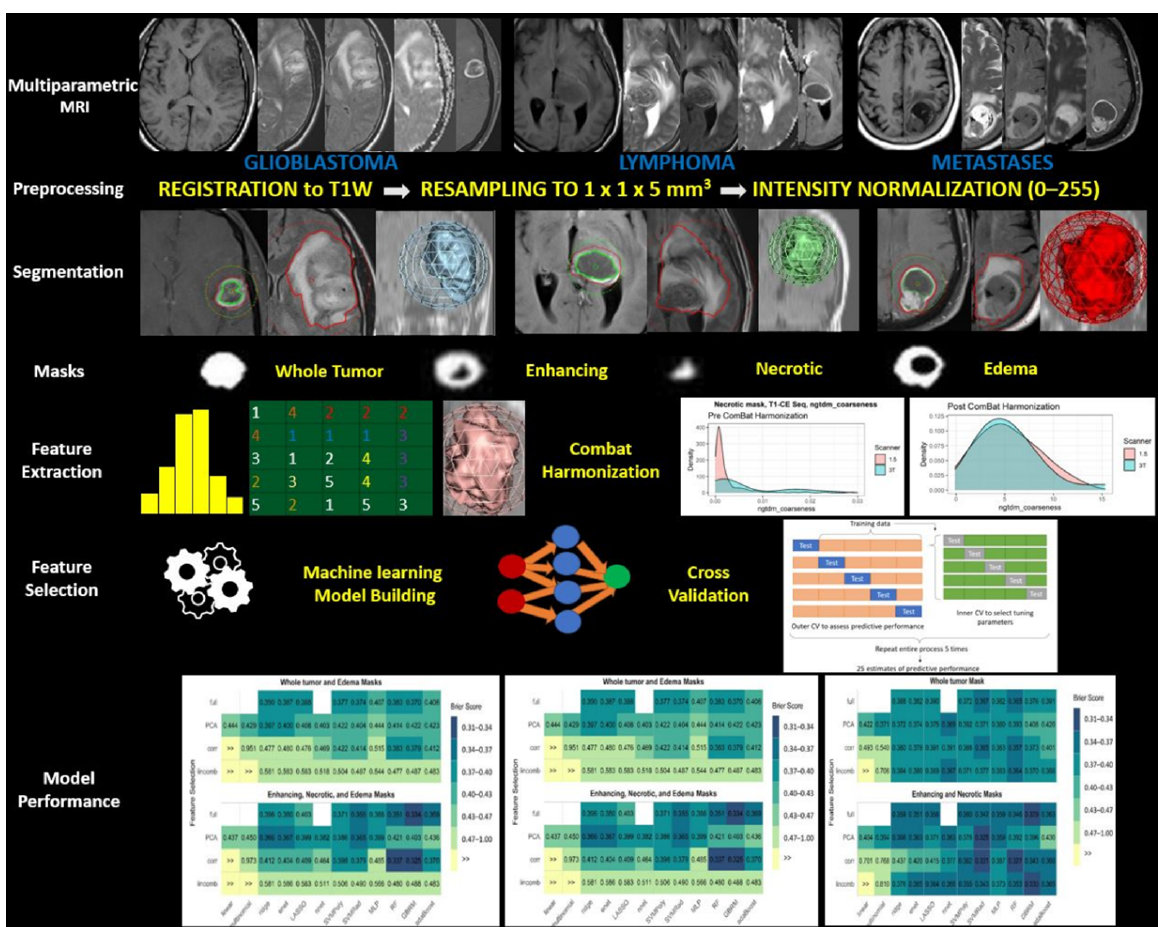
Figure 2. Schematic overview of overall workflow of the study.